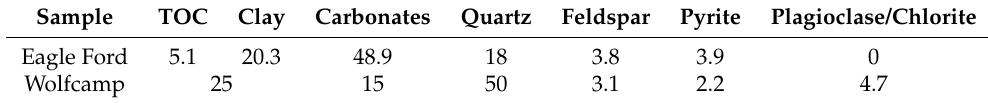
Table 1. Summary of Eagle Ford and Wolfcamp samples mineralogical data by wt%. Data for the Eagle Ford core were obtained from Aljamaan et al. (2017) [30], and the Wolfcamp mineralogical data are based on FTIR data made available by the core provider.